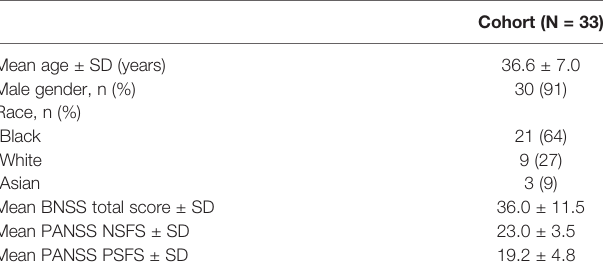
TABLE 1 | Demographics and clinical characteristics at screening.